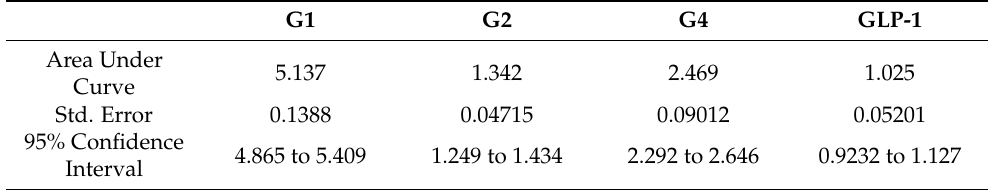
Table A1. Area under curve of DPP-4